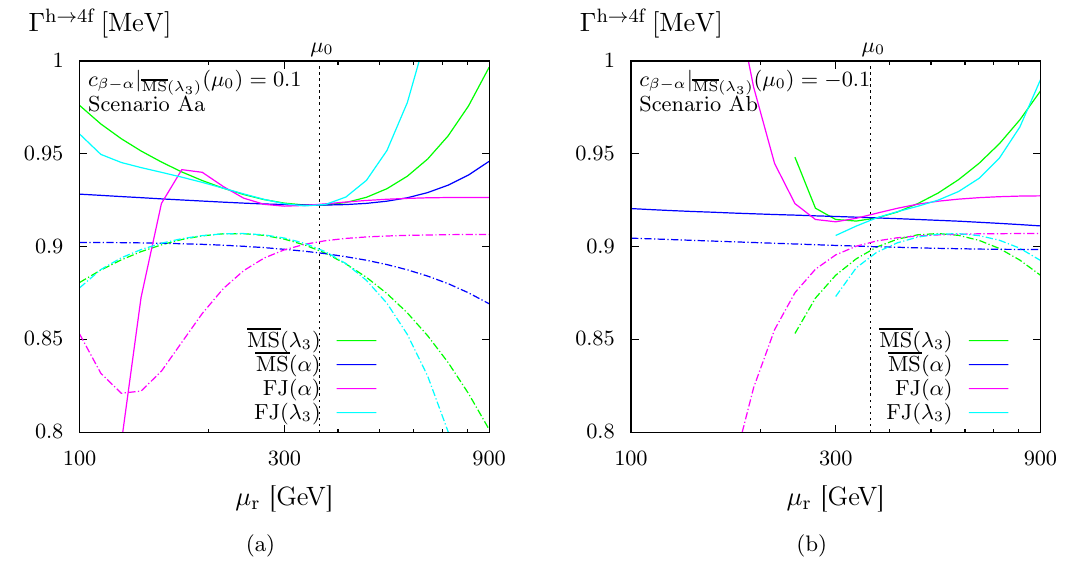
Figure 6 . The decay width for h 4 f at LO (dashed) and NLO EW (solid) in dependence of the ! renormalization scale with (cid:12) and (cid:11) de(cid:12)ned in the MS( (cid:21) 3 ) scheme. The result is computed in all four di(cid:11)erent renormalization schemes after converting the input at NLO (also for the LO curves) and displayed for the benchmark points Aa (a) and Ab (b) using the colour code of (cid:12)gure 5. the (cid:22) r variation) in the major part of THDM parameter space. Our choice (4.67) of (cid:22) 0 e(cid:11)ectively takes care of this and is eventually justi(cid:12)ed by the